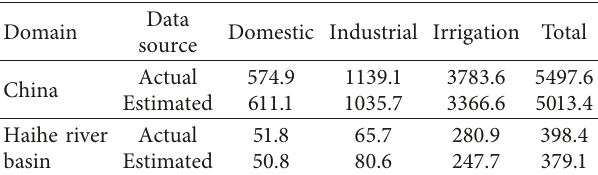
groundwater table, of a mean of 13.86 m. The groundwater table dropped in the areas near Beijing (116.5 ° E, 40.0 ° N), Tianjin (117.0 ° E, 39.0 ° N), and Shijiazhuang (114.5 ° E, 38.0 ° N), corresponding with their high water demands. The